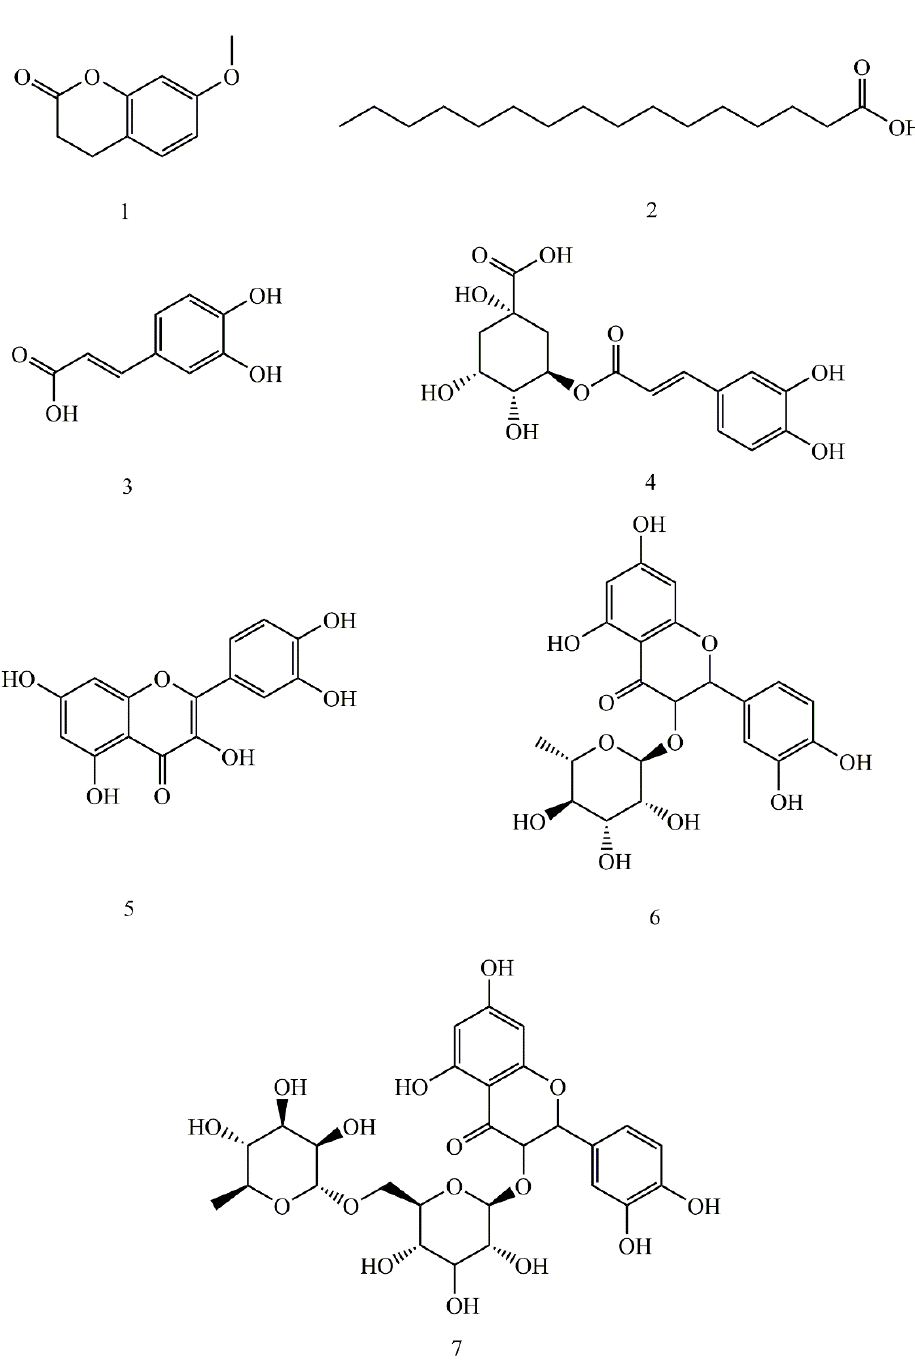
Compound 2 : C 16 H 32 O 2 MS: [M + Na] + C 16 H 32 NaO 2 , measured m/z 279.2295, calculated m/z 279.2300, err 1.8 ppm.